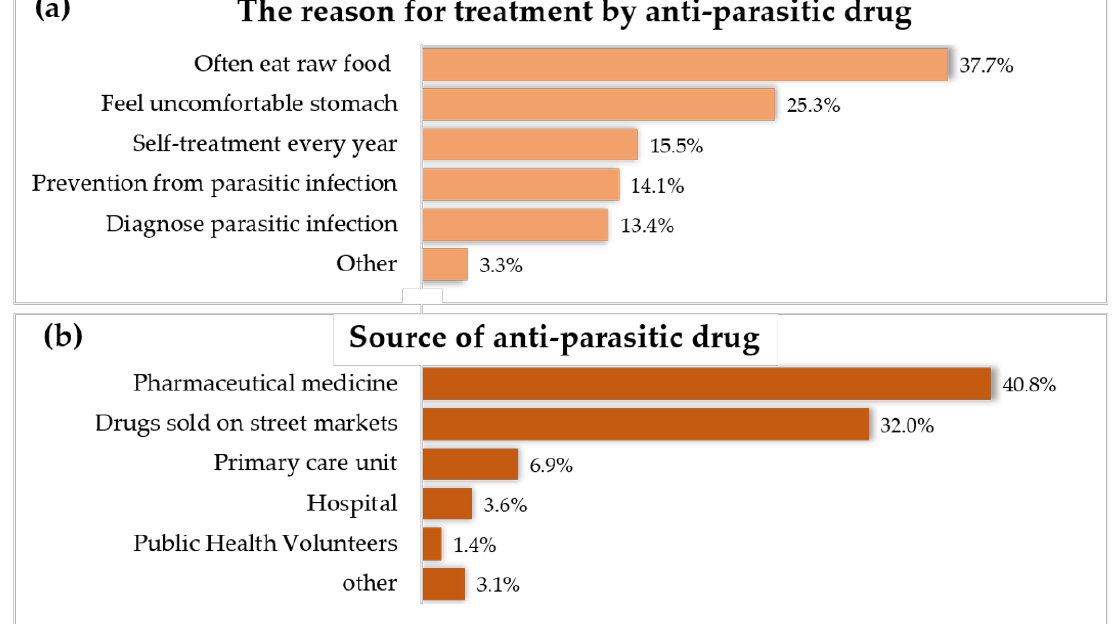
Figure 2. ( a ) Percentages of the reasons for treatment with an anti-parasitic drug; ( b ) source of anti-parasitic drugs. Note: participants could choose more than 1 answer.